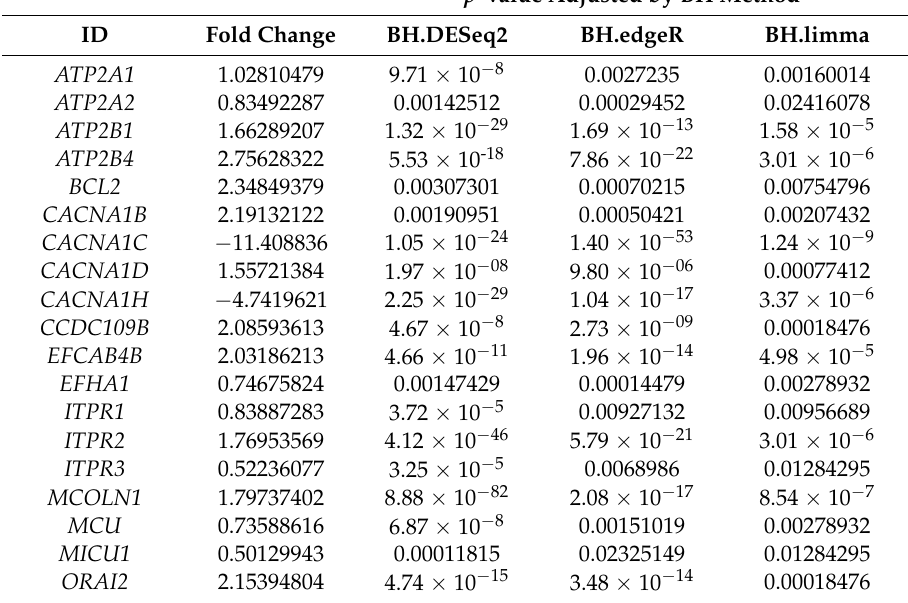
Table 3. Differential gene expression fold change. Fold changes are expressed as 〖 log 〗 _2 (E_Healthy ⁄ E_Tumoral) and E means Expression, and p -values adjusted by Benjamini and Hochberg (BH) method for each different package